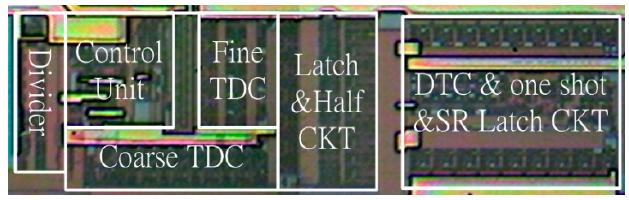
Figure 10. Chip photo.